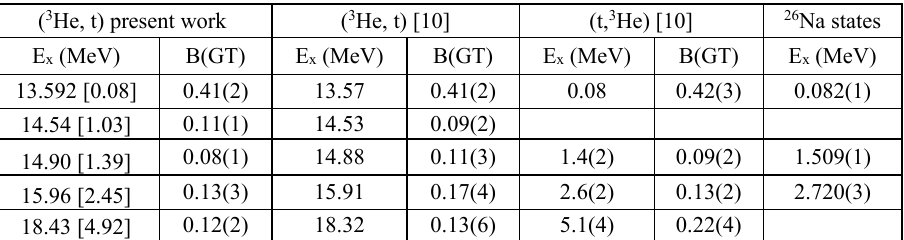
Table 3. Candidates of GT states in the E x = 13.5-18.5 MeV region in 26 Al and in the E x ≤ 5.5 MeV region in 26